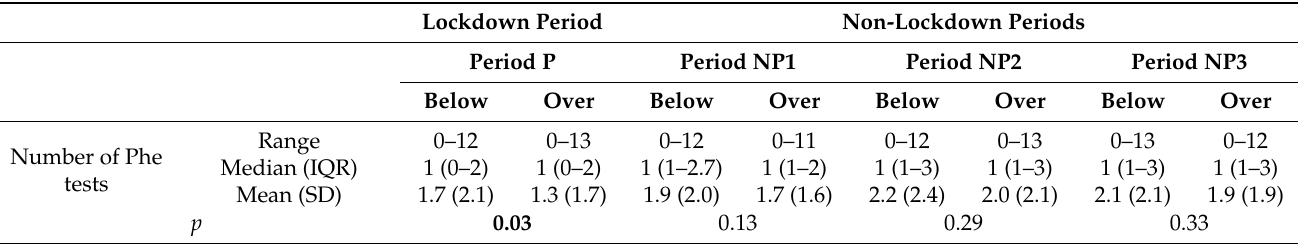
Table 6. The number of phenylalanine (Phe) tests in assessed time intervals (periods P and NP1 to NP3) in patients with yearly (2019) * Phe median below ( n = 258) and over ( n = 264) the median for their age group.